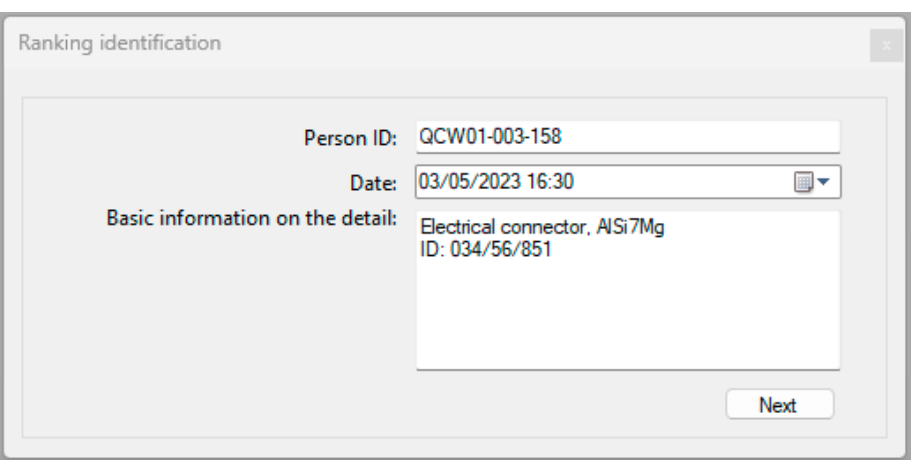
Figure 2. Electrical connector model.